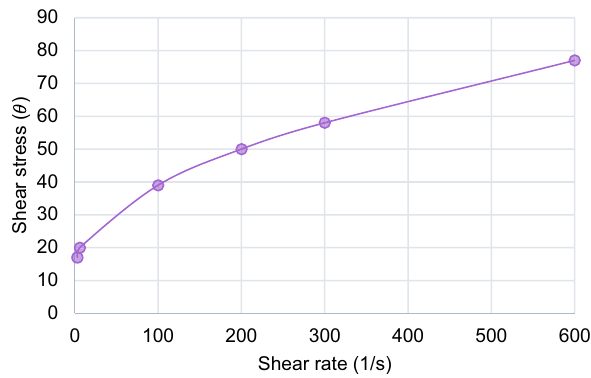
Table 4 LCM's concentration and PSD, when used individually D50 (micron) The weight percentage of total con- centration, if used